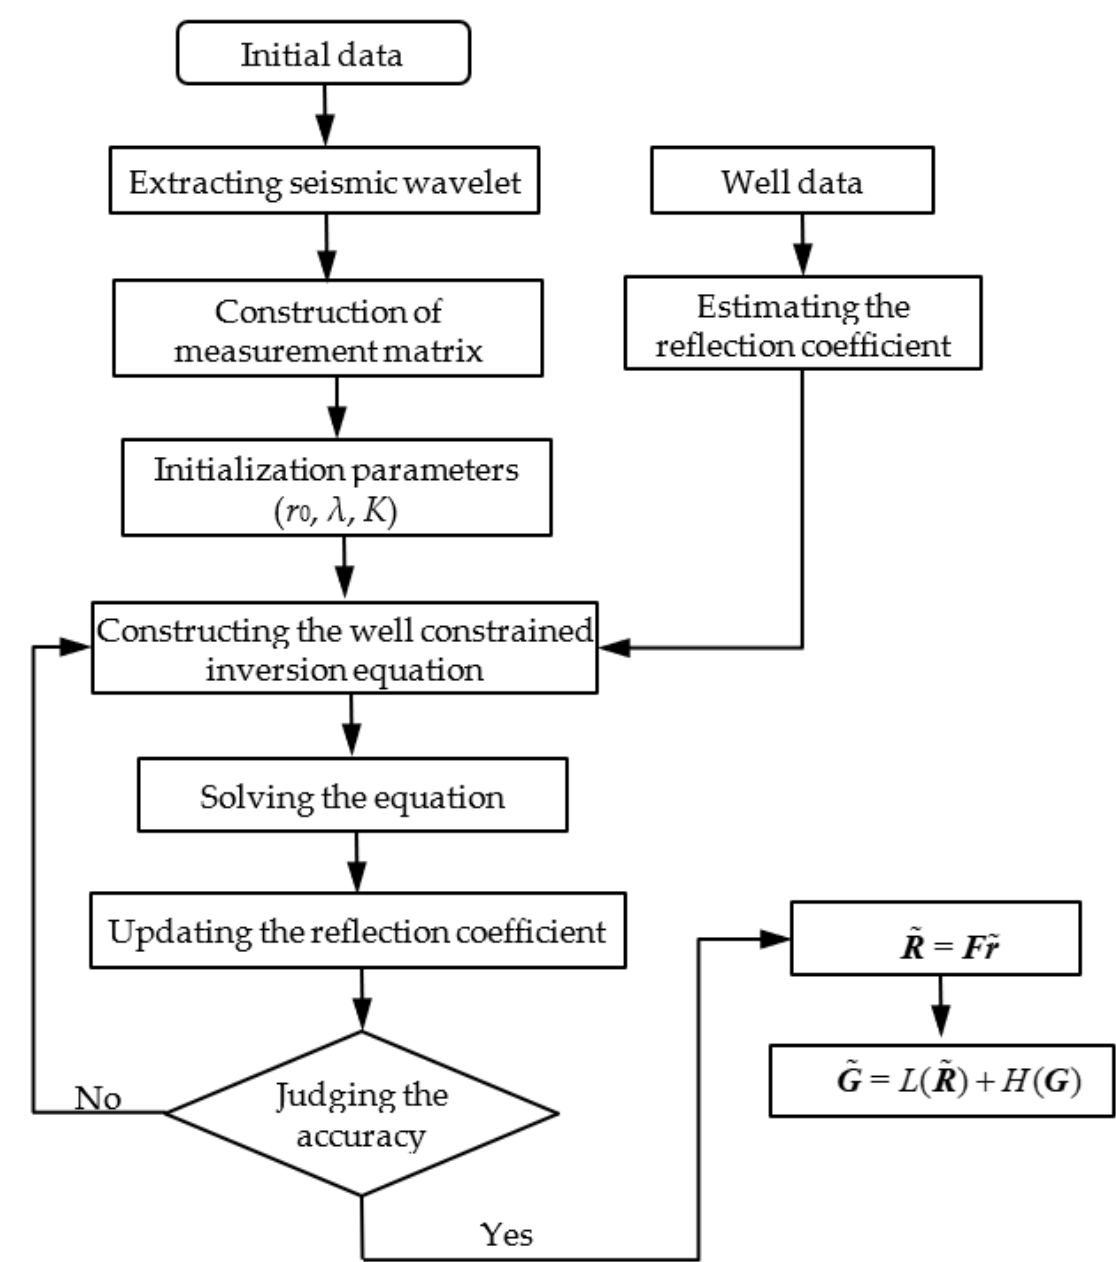
Figure 3. Low-frequency expansion process with well constraint based on CS.